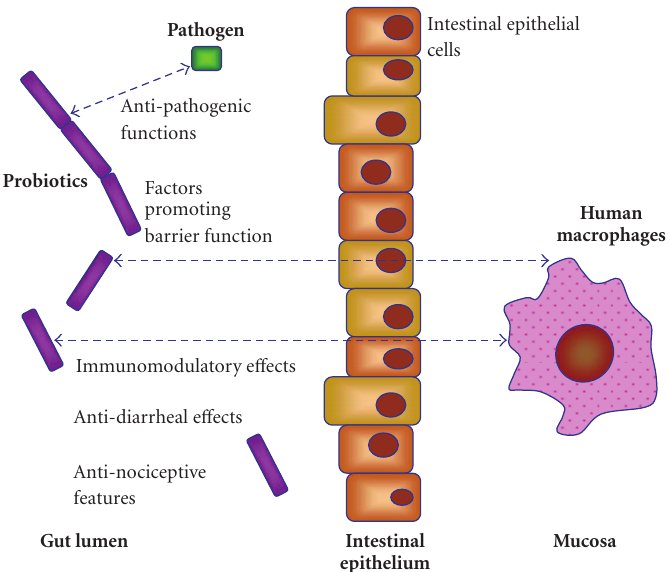
Figure 1: Probiotics and Beneficial E ff ects in the Intestine . Depiction of the interactions between beneficial bacteria (left side), their secreted factors, pathogens, and the intestinal mucosa (right side). Potential beneficial e ff ects of probiotics are listed. Only two host cell types are shown, intestinal epithelial cells and macrophages although other cell types including dendritic cells, lymphocytes, myofibroblasts, and neutrophils comprise the intestinal mucosa. The arrows indicate the release and possible distribution of secreted factors derived from